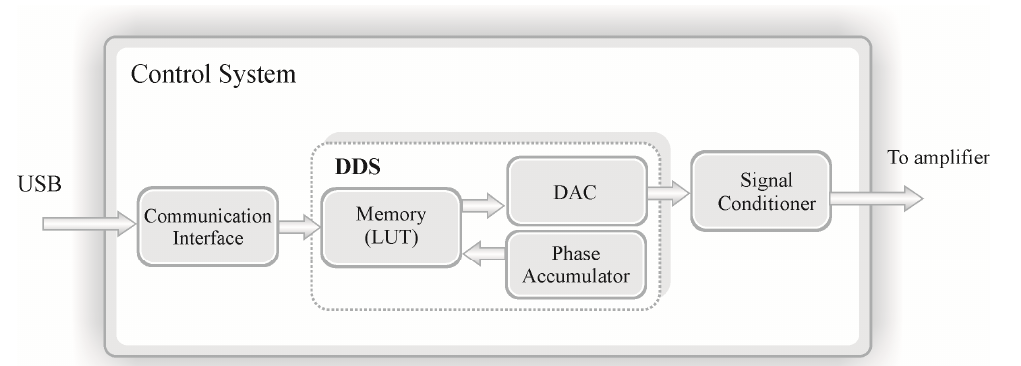
Figure 5. Analyzer module. 3